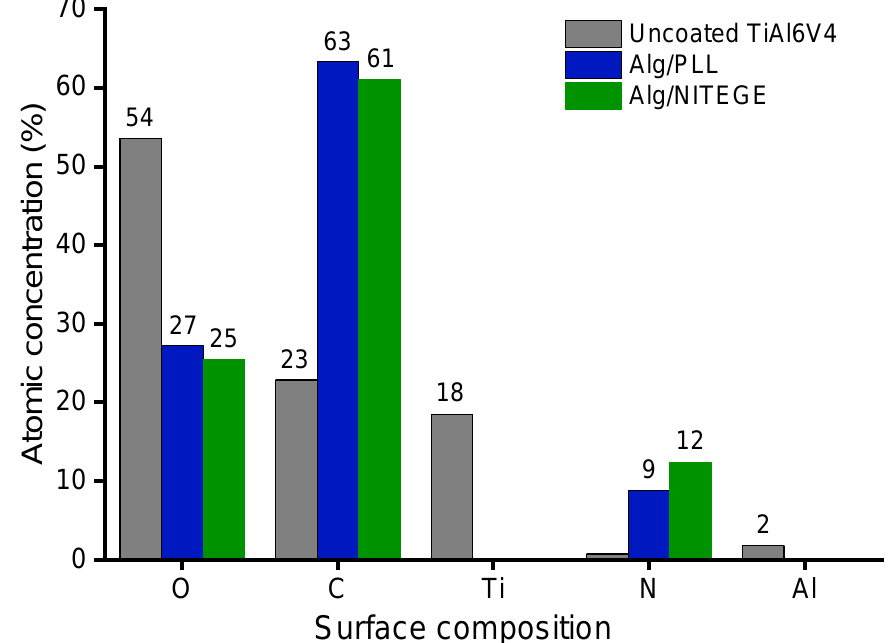
Figure 4. X-ray photoelectron measurement of Alg/peptide coated Ti-6Al-4V substrates and an uncoated Ti-6Al-4V alloy substrate showed the atomic concentration on the surface in percent. Substrates were immersed in polyethyleneimine (PEI) (5% w/w in MilliQ) before Alg/PLL (each 1 mg/mL in MilliQ, volume ratio 4:1), and Alg/NITEGE (each 1 mg/mL, volume ratio 1:1) nanoparticle suspensions were spray-coated onto the